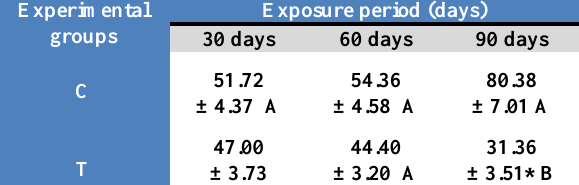
Table, 2: Body weight (gm) changes of Cyprinus carpio exposed to contaminated feed with A.